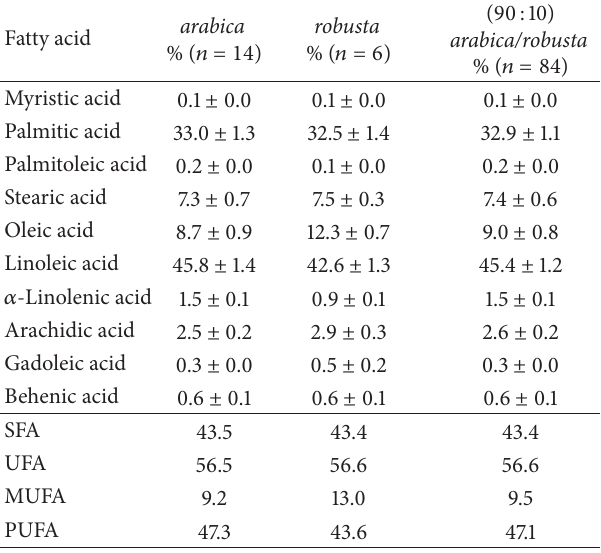
Figure2:CharacteristicHRGCprofileoftheFAMEofTAGfraction ofacoffeesample.(1)Myristicacid(C14:0),(2)palmiticacid(C16:0), (3) palmitoleic acid (C16:1 n-7), (4) stearic acid (C18:0), (5) oleic acid (C18:1 n-9), (6) linoleic acid (C18:2 n-6), (7) 𝛼 -linolenic acid (C18:3 n-3), (8) arachidic acid (C20:0), (9) gadoleic acid (C20:1 n-11), and (10) behenic acid (C22:0). Table 1: Total fatty acid composition (% mol, mean value ± SD) of triacylglycerol fraction of arabica , robusta , and (90:10) arabica / robusta